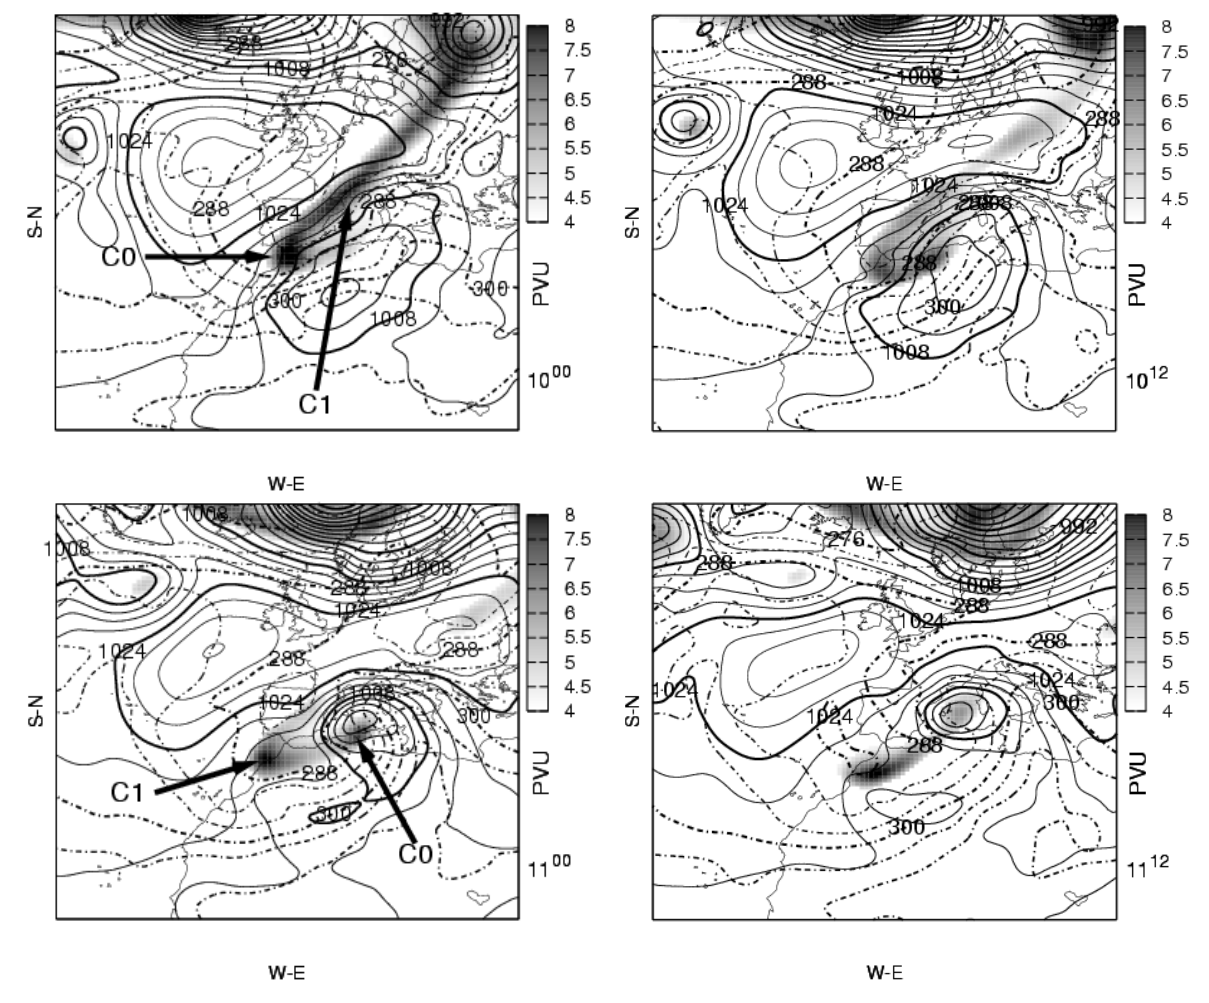
Fig. 1. Sea level pressure (every 4hPa, solid line), Potential temperature at 850hPa (every 4K, dashed line) and Isentropic Ertel PV at 12:00UTC (top right), 11 November at 00:00UTC (bottom left) and 11 November at 12:00UTC (bottom